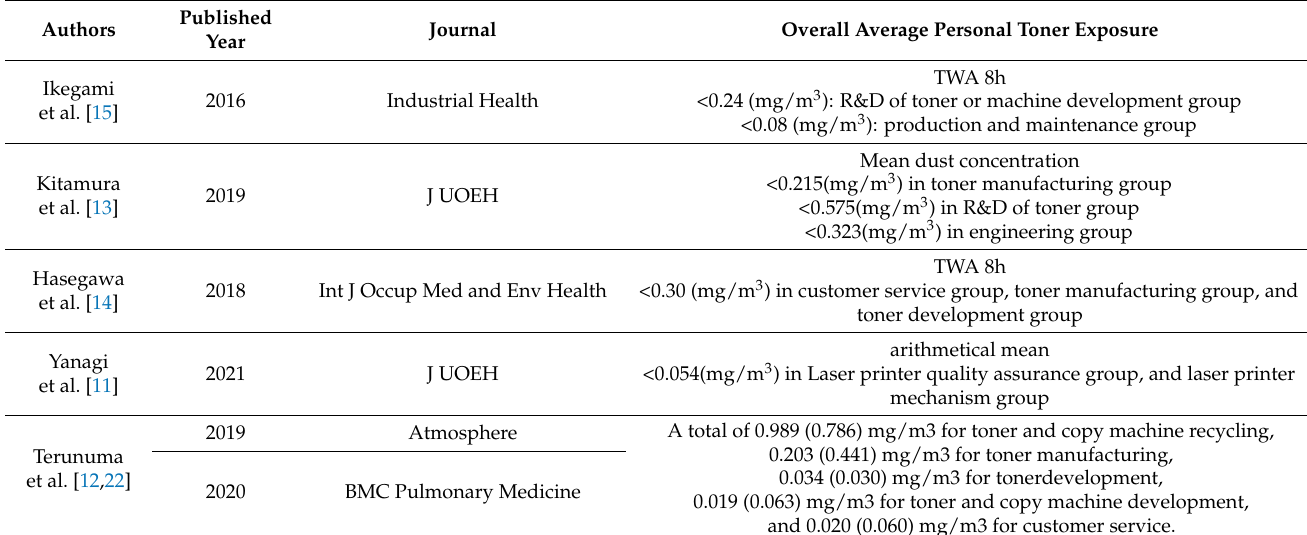
Table 3. Exposure concentrations in the work environment in five